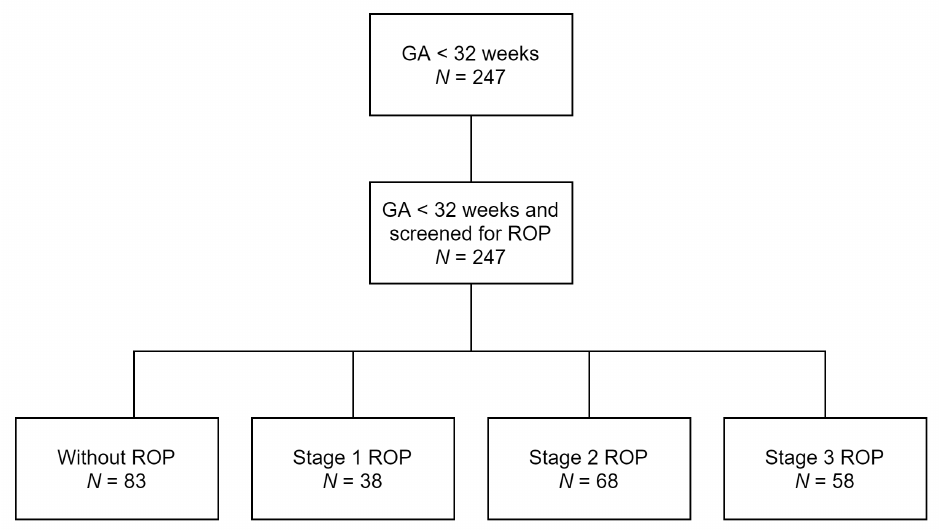
Figure 1. Distribution of infants in the study.